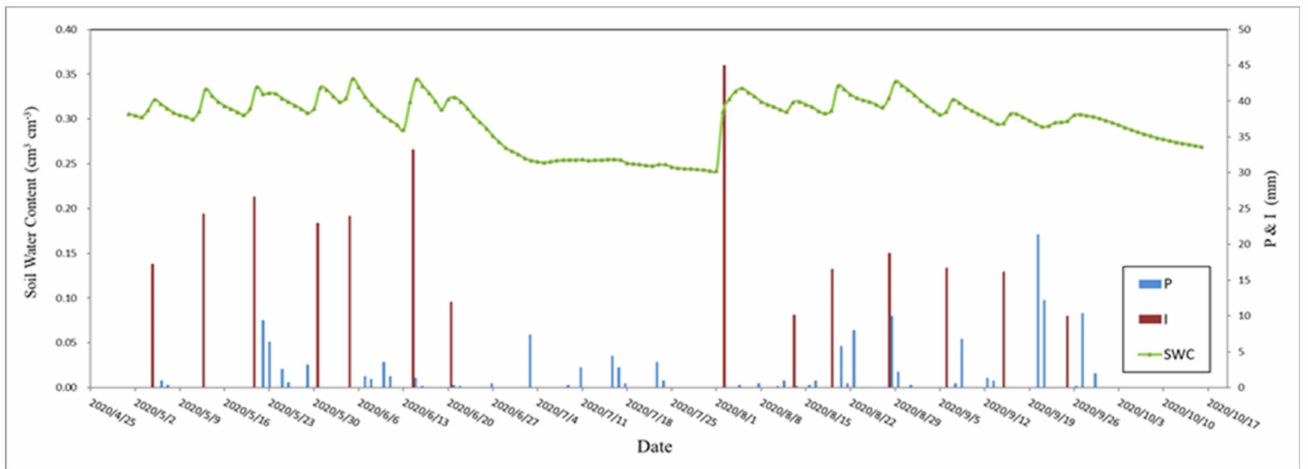
Figure 1. The precipitation (P) and irrigation (I) volumes and the diurnal variation in soil water content (SWC) of Chinese cabbage throughout the observation